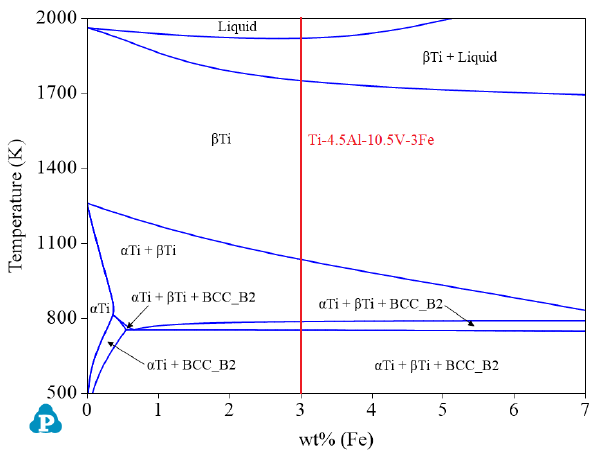
Figure 11. The calculated pseudo-binary section of V:Fe = 3.5:1 and 4.5 wt% Al.